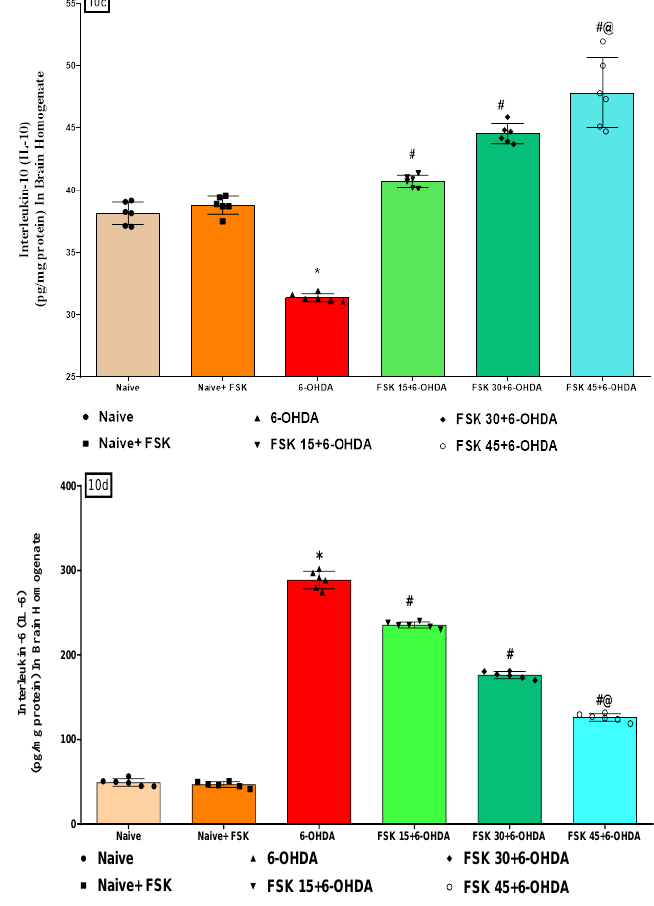
Figure 10. ( a – d ) FSK modulated inflammatory cytokines in the experimental model of PD. Data provided as mean ± SD (n = 6) followed by ANOVA (one-way) with post-hoc Tukey’s test . * 6-OHDA ( p < 0.01) compared with naive and naive + FSK; # FSK15, FSK30, FSK45 (p < 0.01) compared with 6-OHDA ; #@ FSK45 (p < 0.01) compared with FSK30, FSK15 .